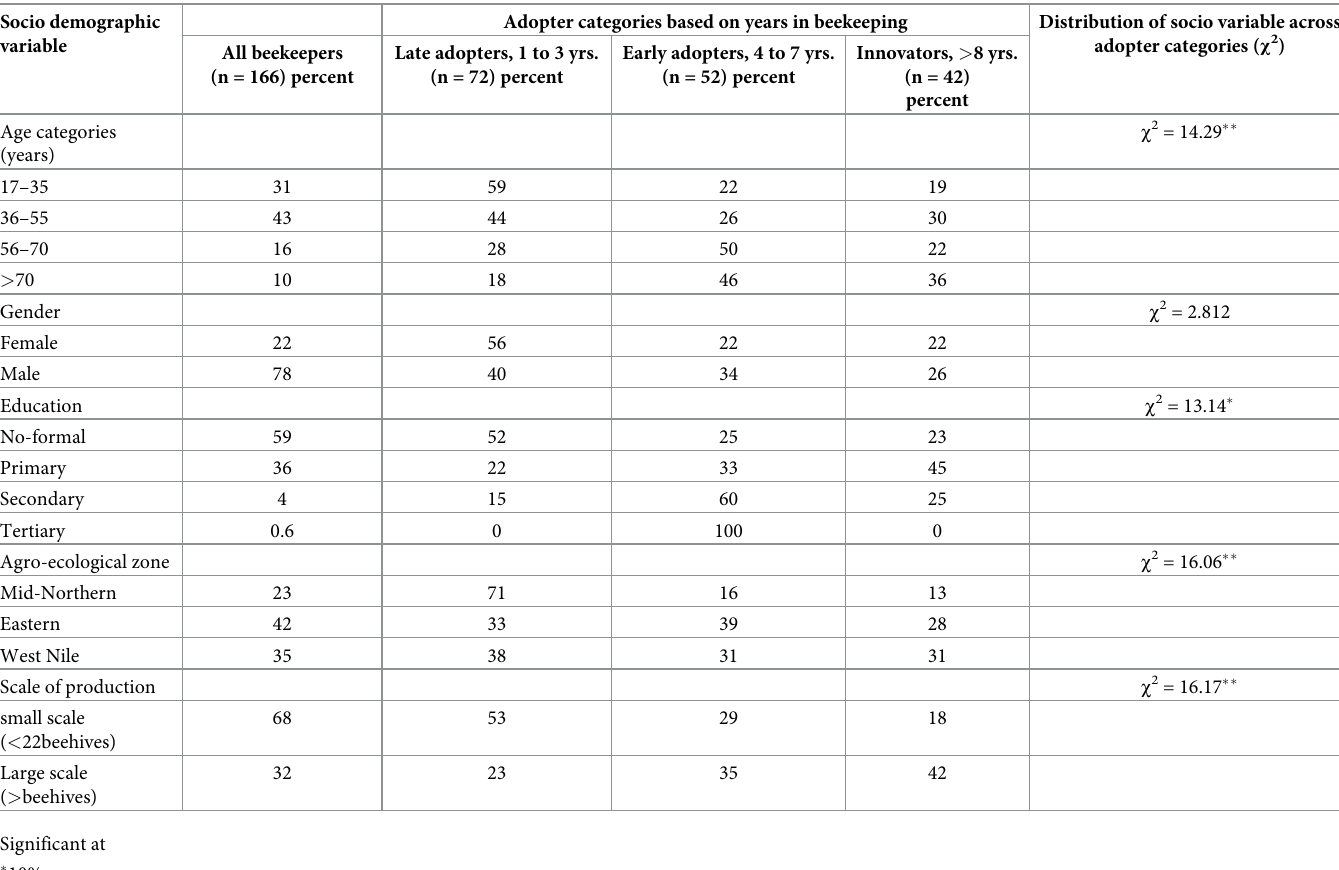
Table 2. Socio-demographic characteristics of